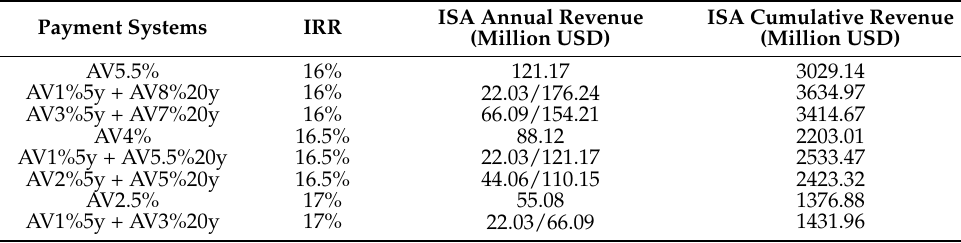
Table 10. Economic metrics of the project with different payment systems. Figure 8. After-tax IRR with different royalty rates and metal prices.